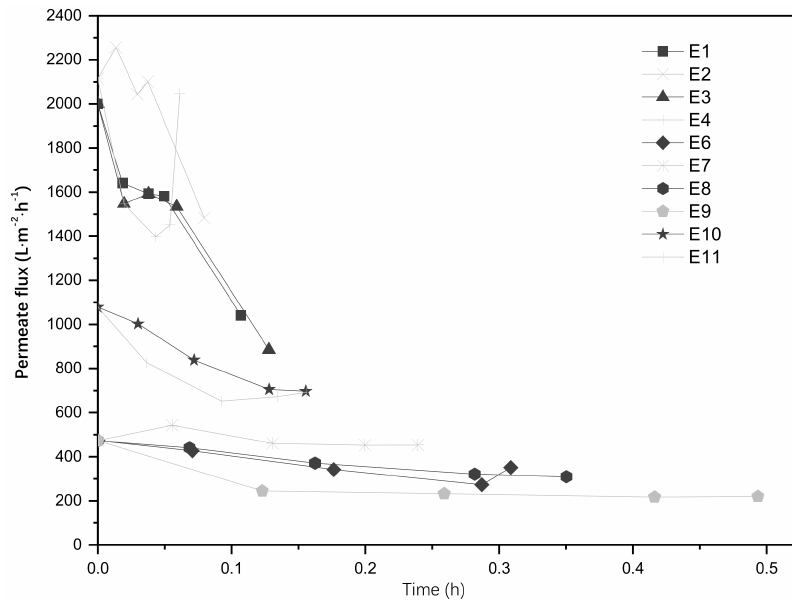
Figure 2. Permeate flux comparison between membranes with different catalyst